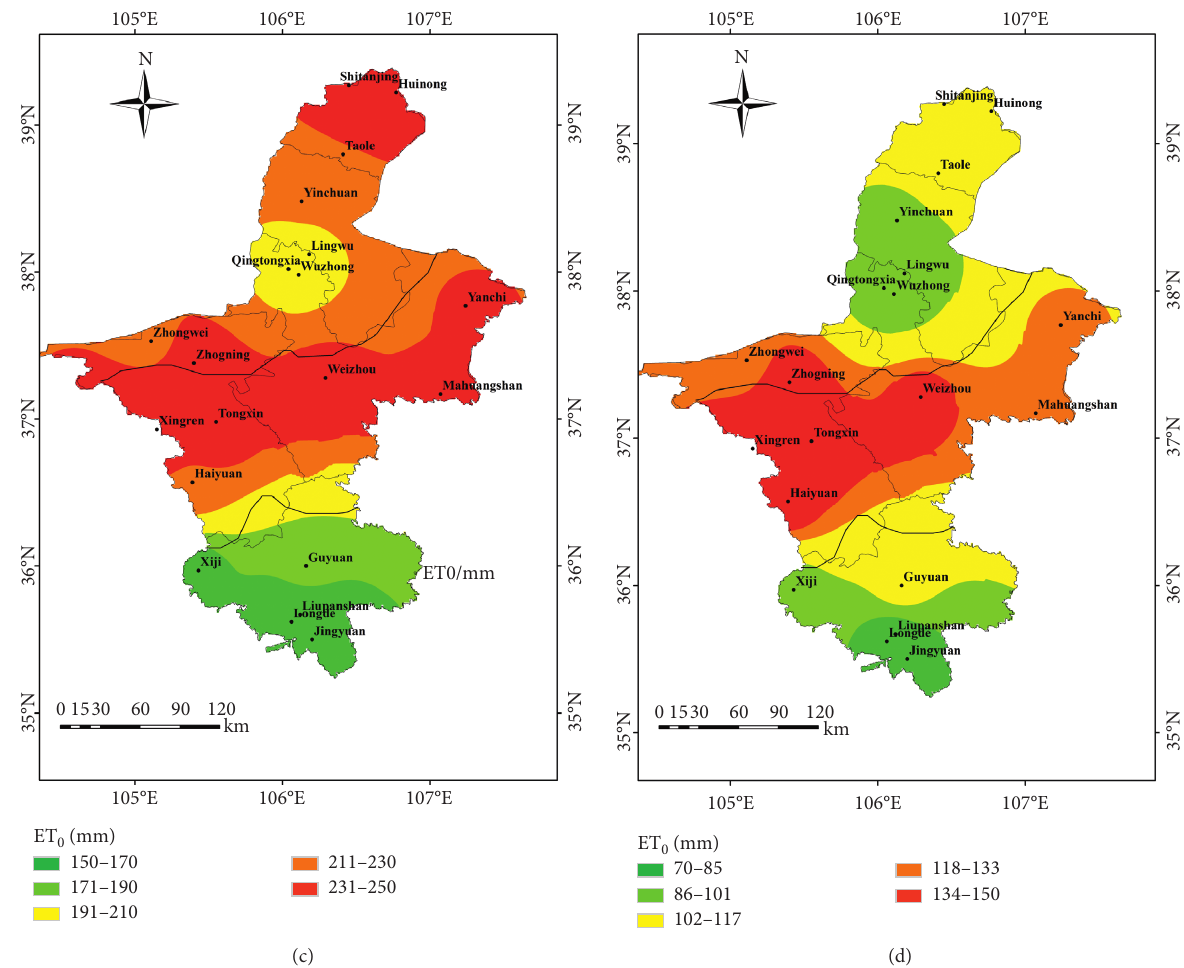
Figure 9: Spatial distribution of average ET 0 at different times: (a) spring; (b) summer; (c) autumn; (d) winter.